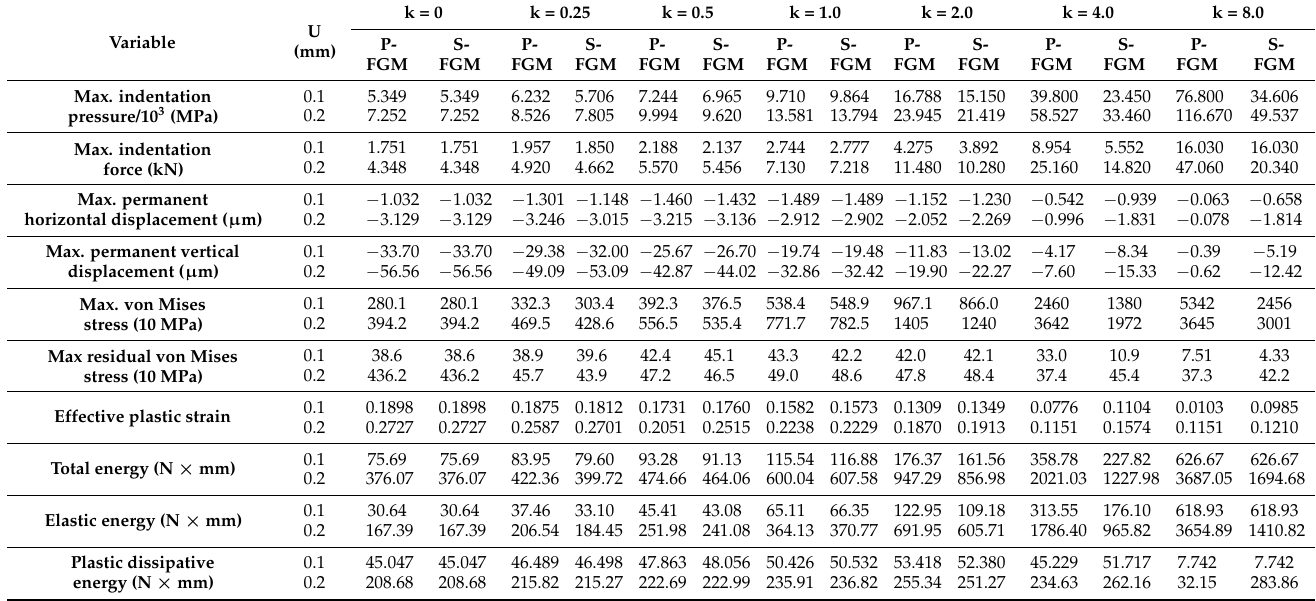
Table 1. Summary of the different indentation variables at an applied displacement U = 0.1 and 0.2 mm.